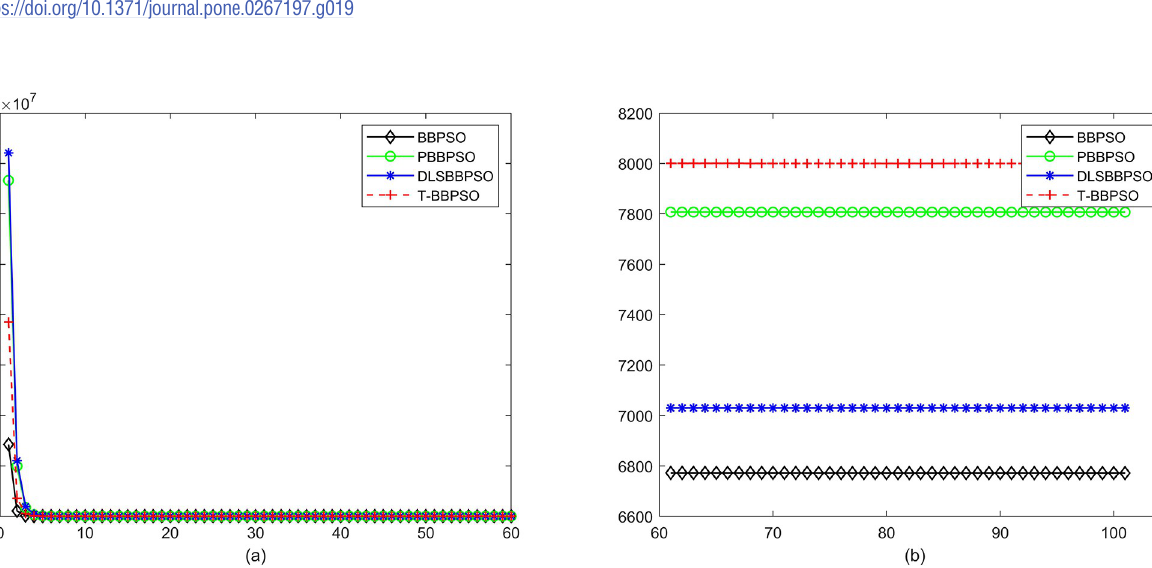
Fig 20. Comparison of convergence speed between BBPSO, PBBPSO, DLS-BBPSO and TBBPSO, f 18 , (a) iteration 0–6000, (b) iteration 6000–10000 the unit is 100 iteration.